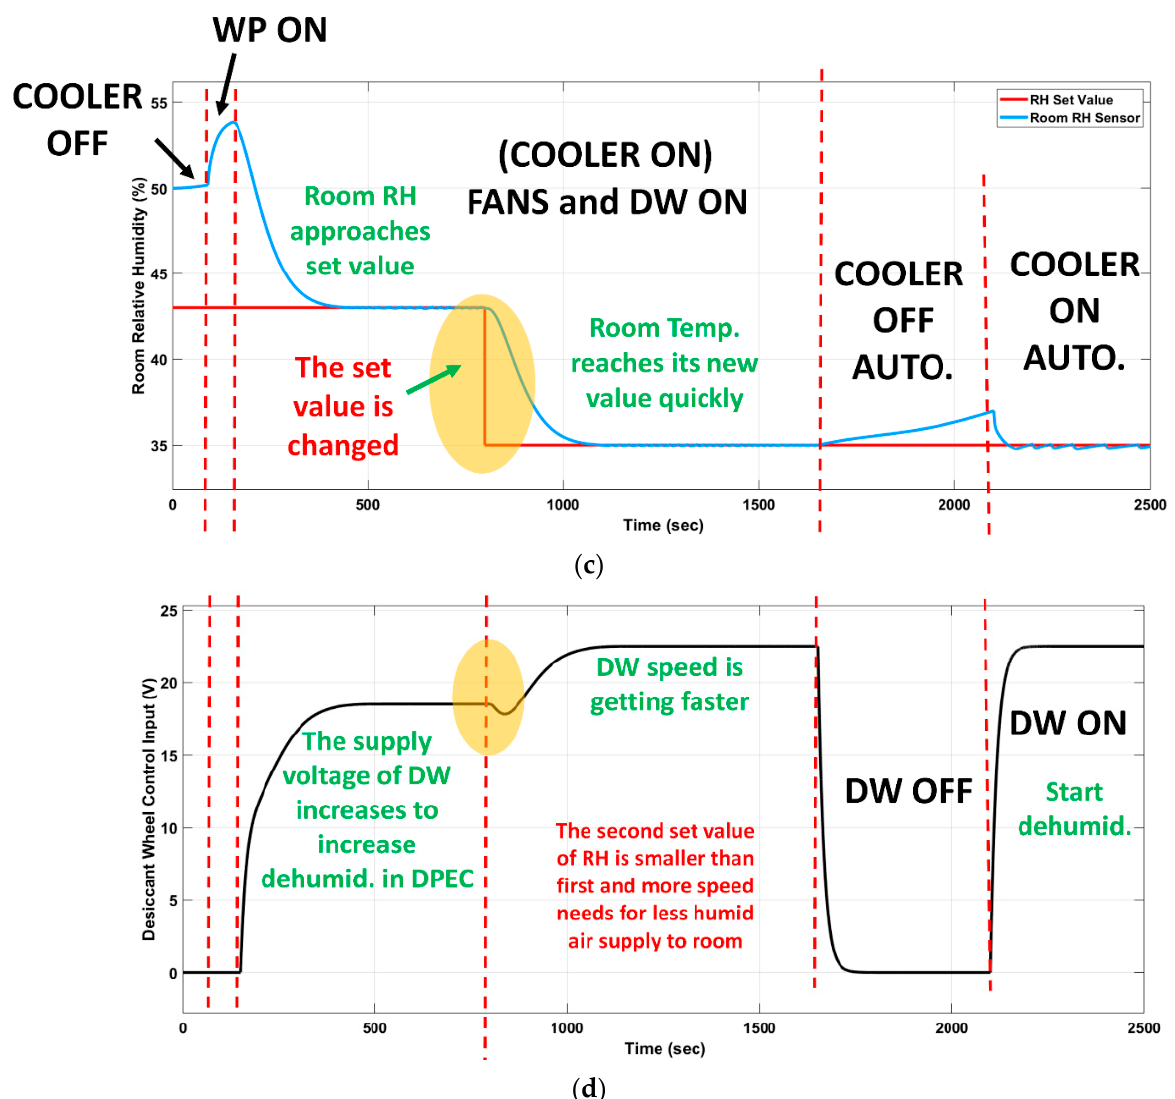
Figure 3. ( a ) The variations in the room temperature. ( b ) The control input of a fan. ( c ) The variations in the room relative humidity. ( d ) The control input of the desiccant wheel.